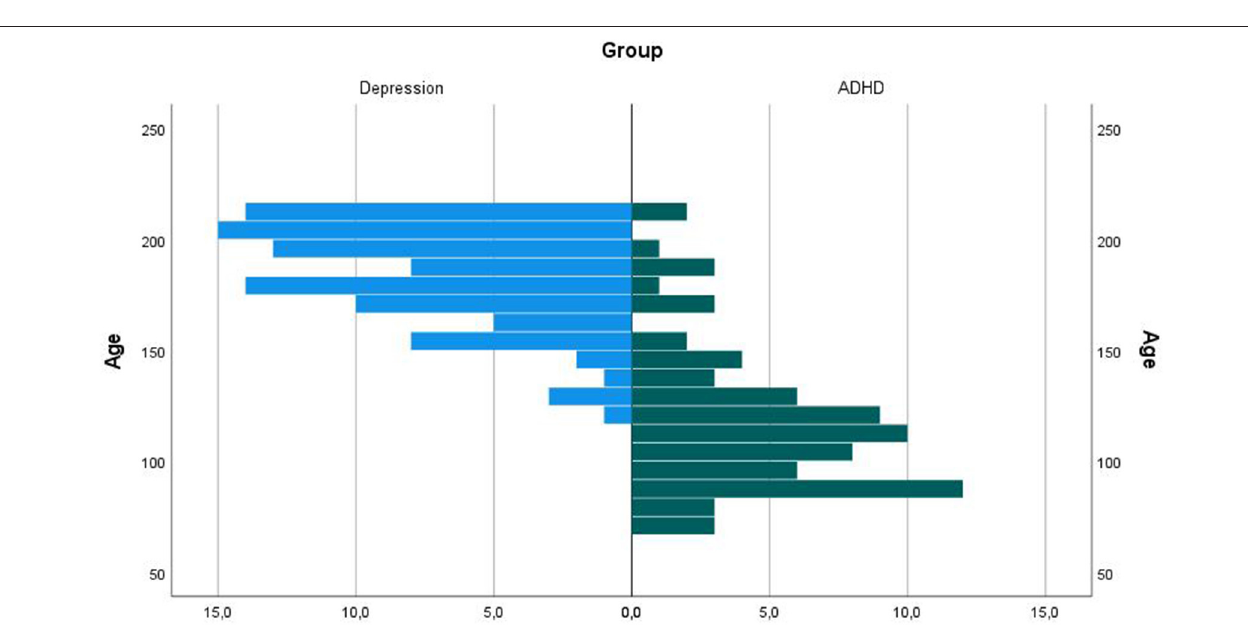
Frontiers in Psychiatry |